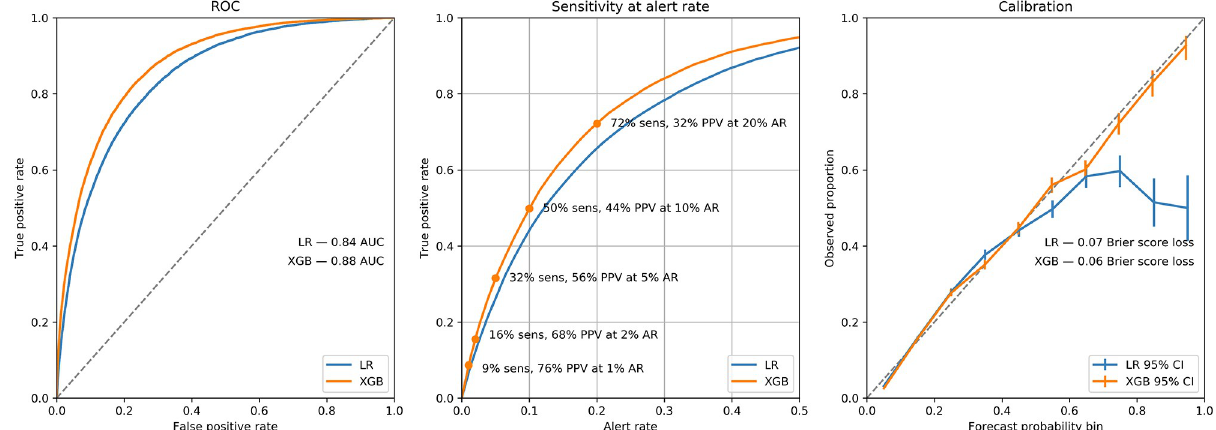
Fig 2. Test data algorithm performance comparisons for predicting 30-day mortality. The left panel displays the full area under the curve (AUC) for logistic regression (LR) algorithm vs extreme gradient boosted (XGB) algorithm. The middle panel displays the true positive rate vs the alert rate (e.g. 1% alert rate would capture the 1% at highest risk for 30-day mortality) at selected alert rates (1%, 2%, 5%, 10%, and 20%), along with details about the sensitivity and positive predictive value (precision) at those alert rates for the LR and XGB models. The right panel of displays calibration curves along with the Brier score loss–an indication of the overall calibration of the LR and XGB models.